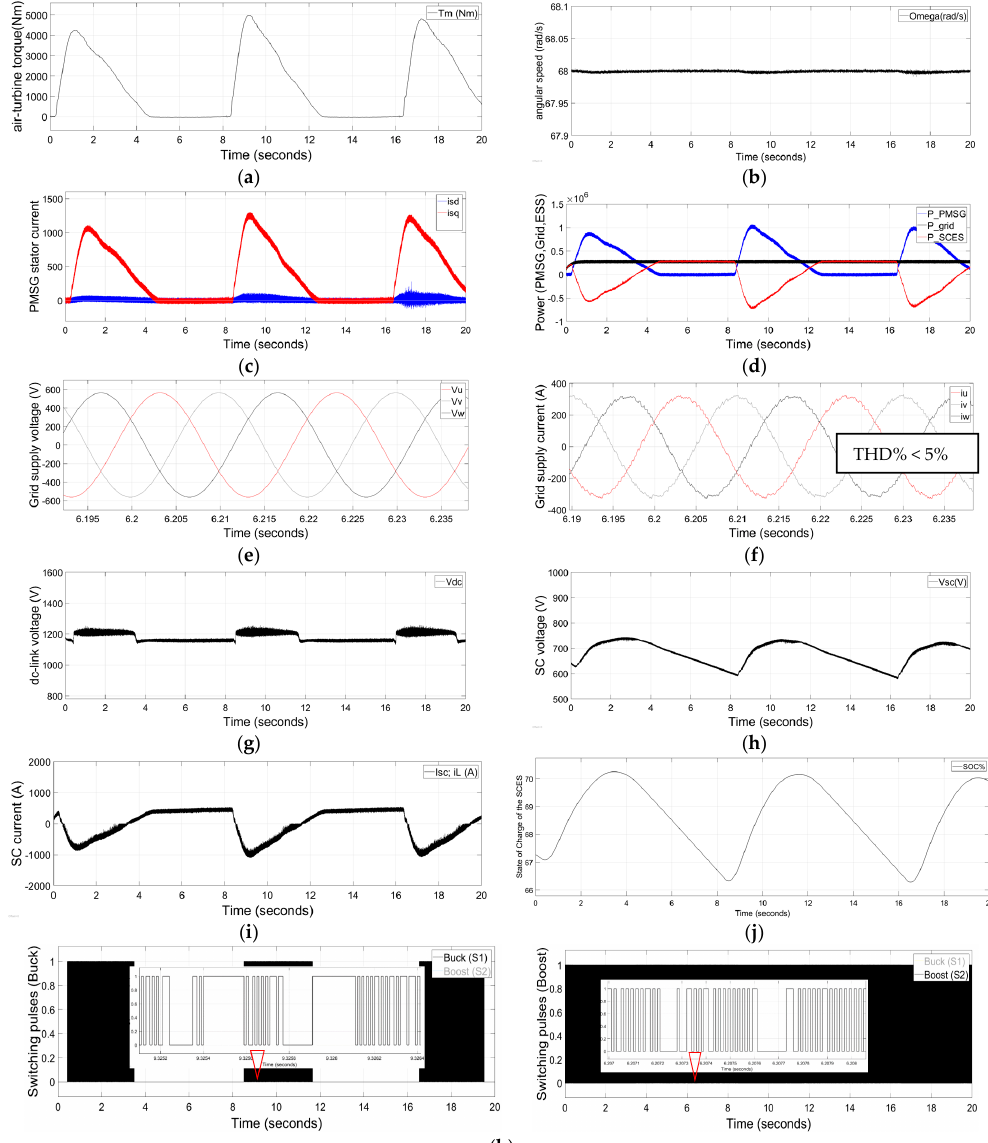
Figure 6. The simulation results of the OWC grid-integrated system with SCES; ( a ) mechanical torque profile ( T m ); ( b ) generator rotor angular speed ( ω m ); ( c ) PMSG stator current in dq frame ( i sd and i sq ); ( d ) power (PMSG, grid, SCES); ( e ) grid voltage ( v g ); ( f ) grid current ( i g ); ( g ) dc-link voltage ( v dc ); ( h ) supercapacitor voltage ( v sc ); ( i ) inductor current ( i L ); ( j ) state of charge of the SCES (SOC); and ( k ) dc-dc bidirectional converter switching